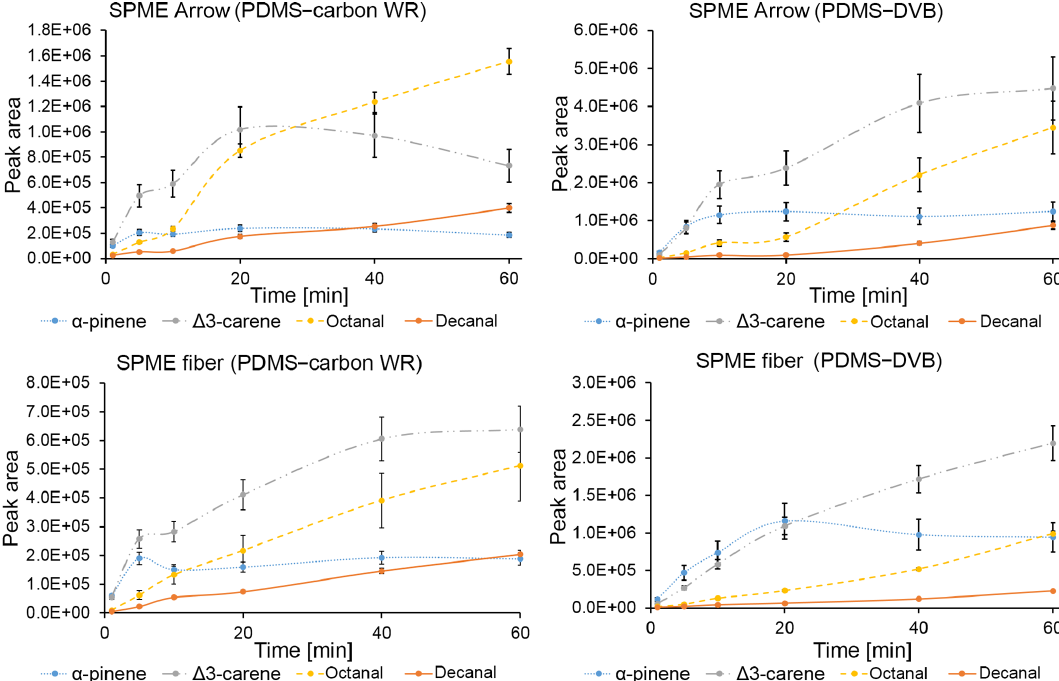
Figure 1. Extraction time profiles obtained for the studied analytes using SPME fiber and SPME Arrow coated with PDMS–carbon WR and